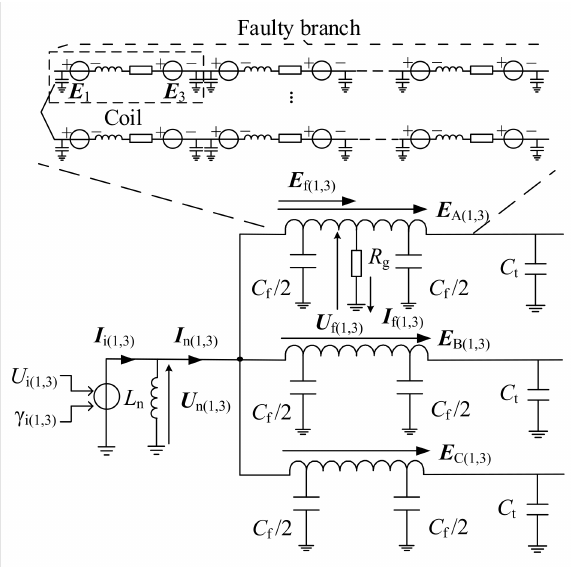
Figure 1. Generatorstator-windingschematic diagrambased onthe hybridflexibleneutral groundingmode.